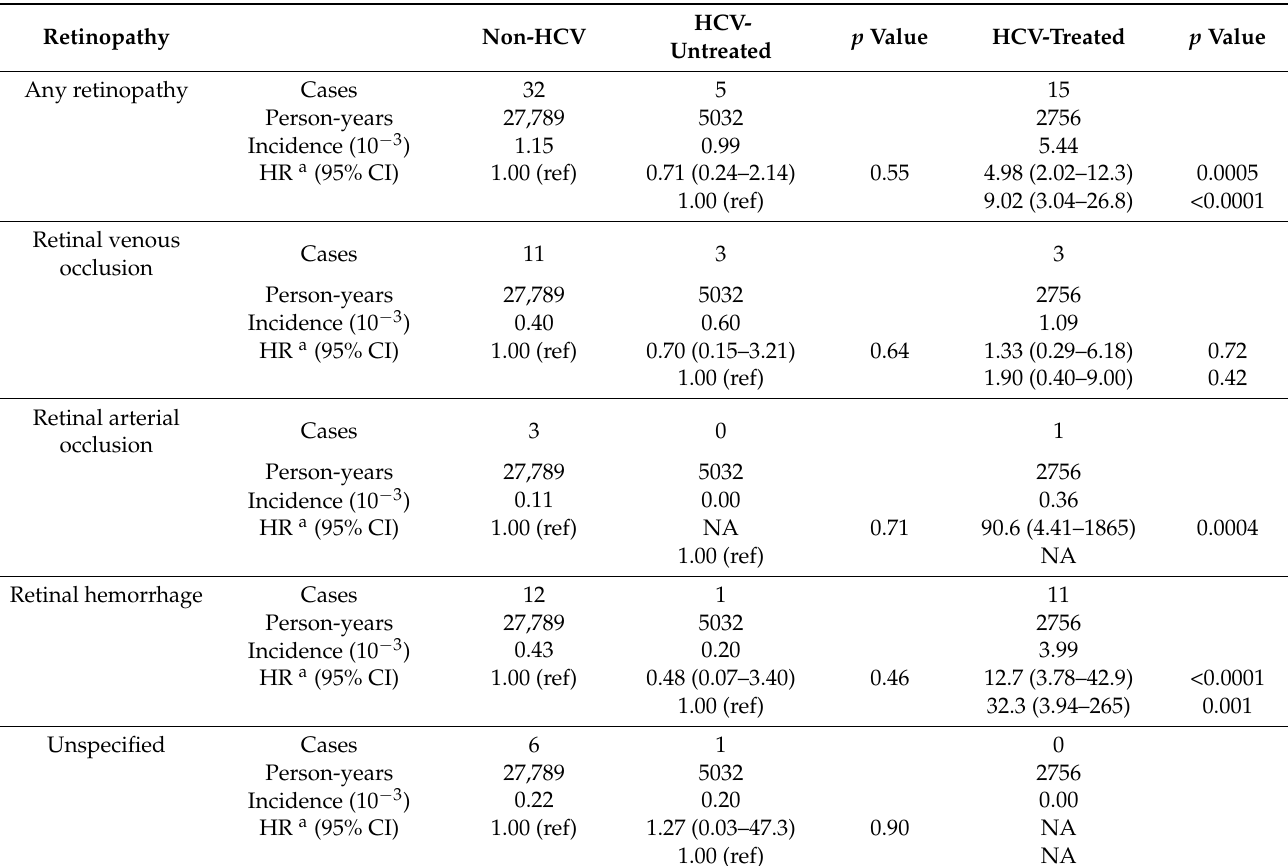
Table 2. Incidence rates and hazard ratios for the risk of retinopathy among the non-HCV, HCV-untreated, and HCV-treated cohorts.